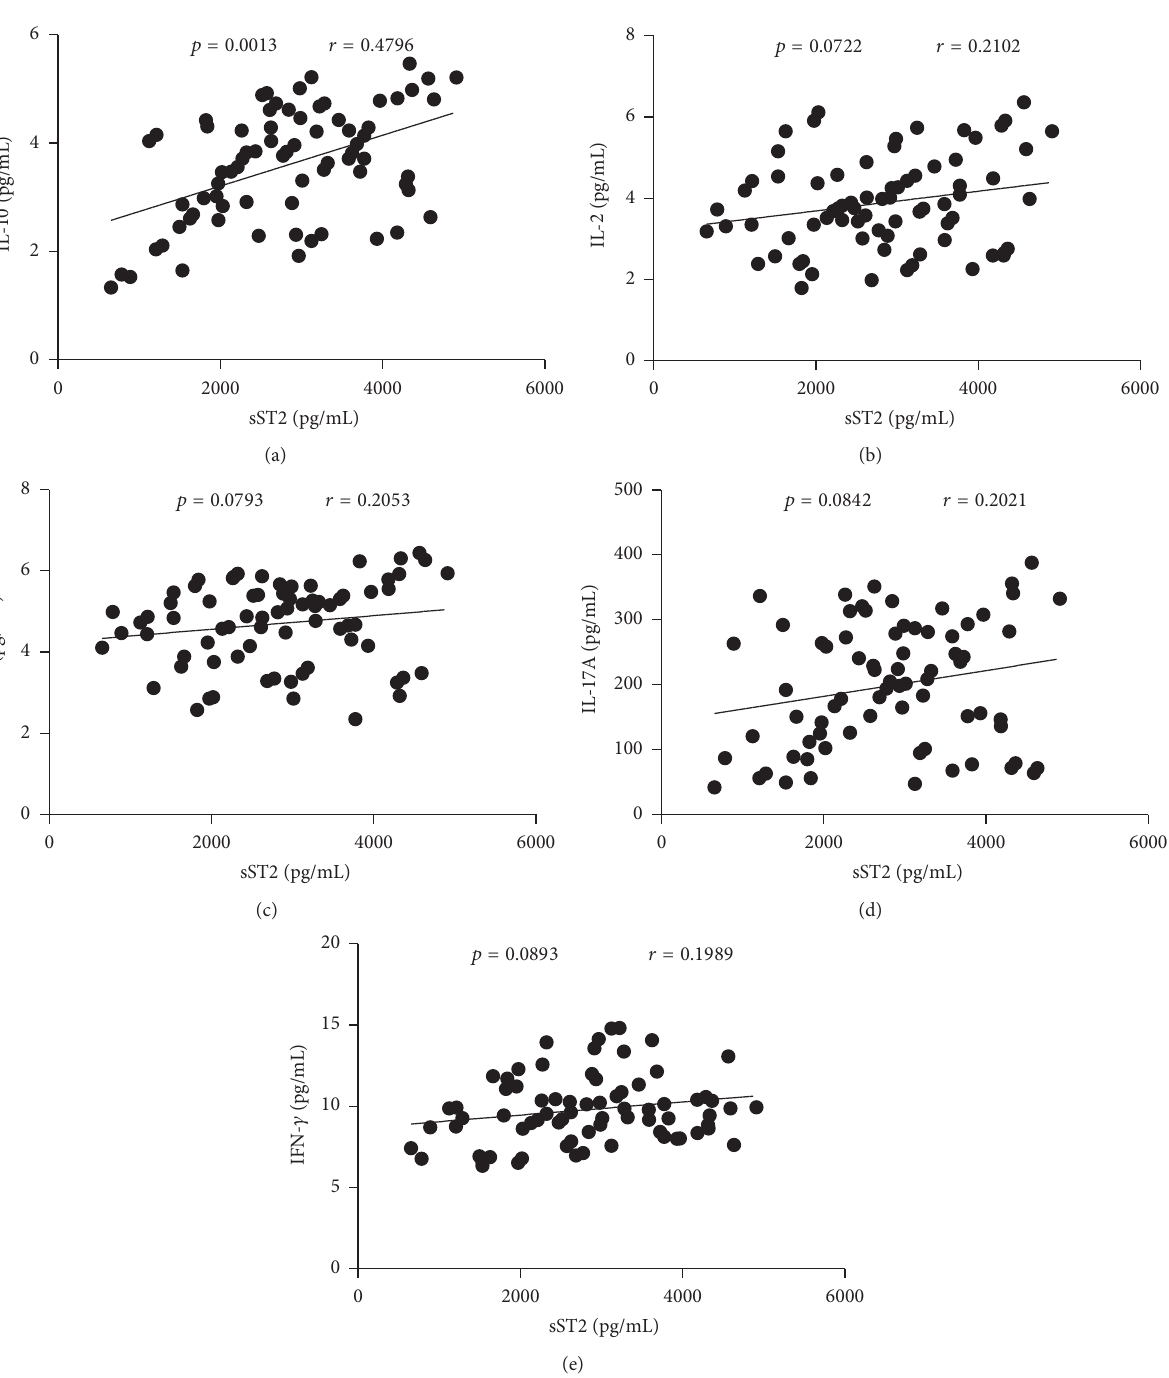
Figure 5: Correlation analysis of serum sST2 with the levels of IL-2, IL-4, IL-10, IL-17A, and IFN- 𝛾 in IgAN patients. The potential correla- tions between serum sST2 and the levels of IL-2, IL-4, IL-10, IL-17A, and IFN- 𝛾 were analyzed by Spearman correlation tests. Data shown are the mean concentration of individual subjects from two separate experiments. (a) Serum sST2 levels were correlated positively with IL-10. ((b)–(e)) No correlation was found between serum sST2 and the levels of IL-2, IL-4, IL-17A, and IFN- 𝛾 in IgAN patients,